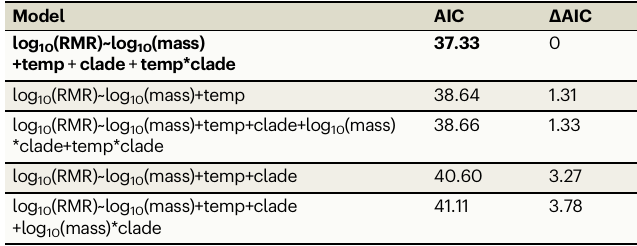
Table 1 | Model selection based on Akaike Information Cri- terion (AIC) with clade (teleost or elasmobranch) as a cate- gorical predictor variable